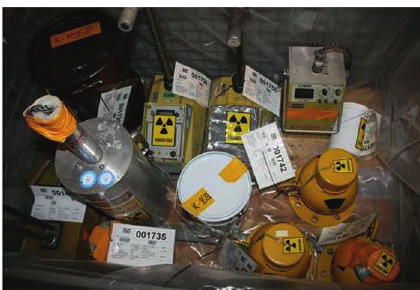
Figure 1: Transport of radioactive material (photo: